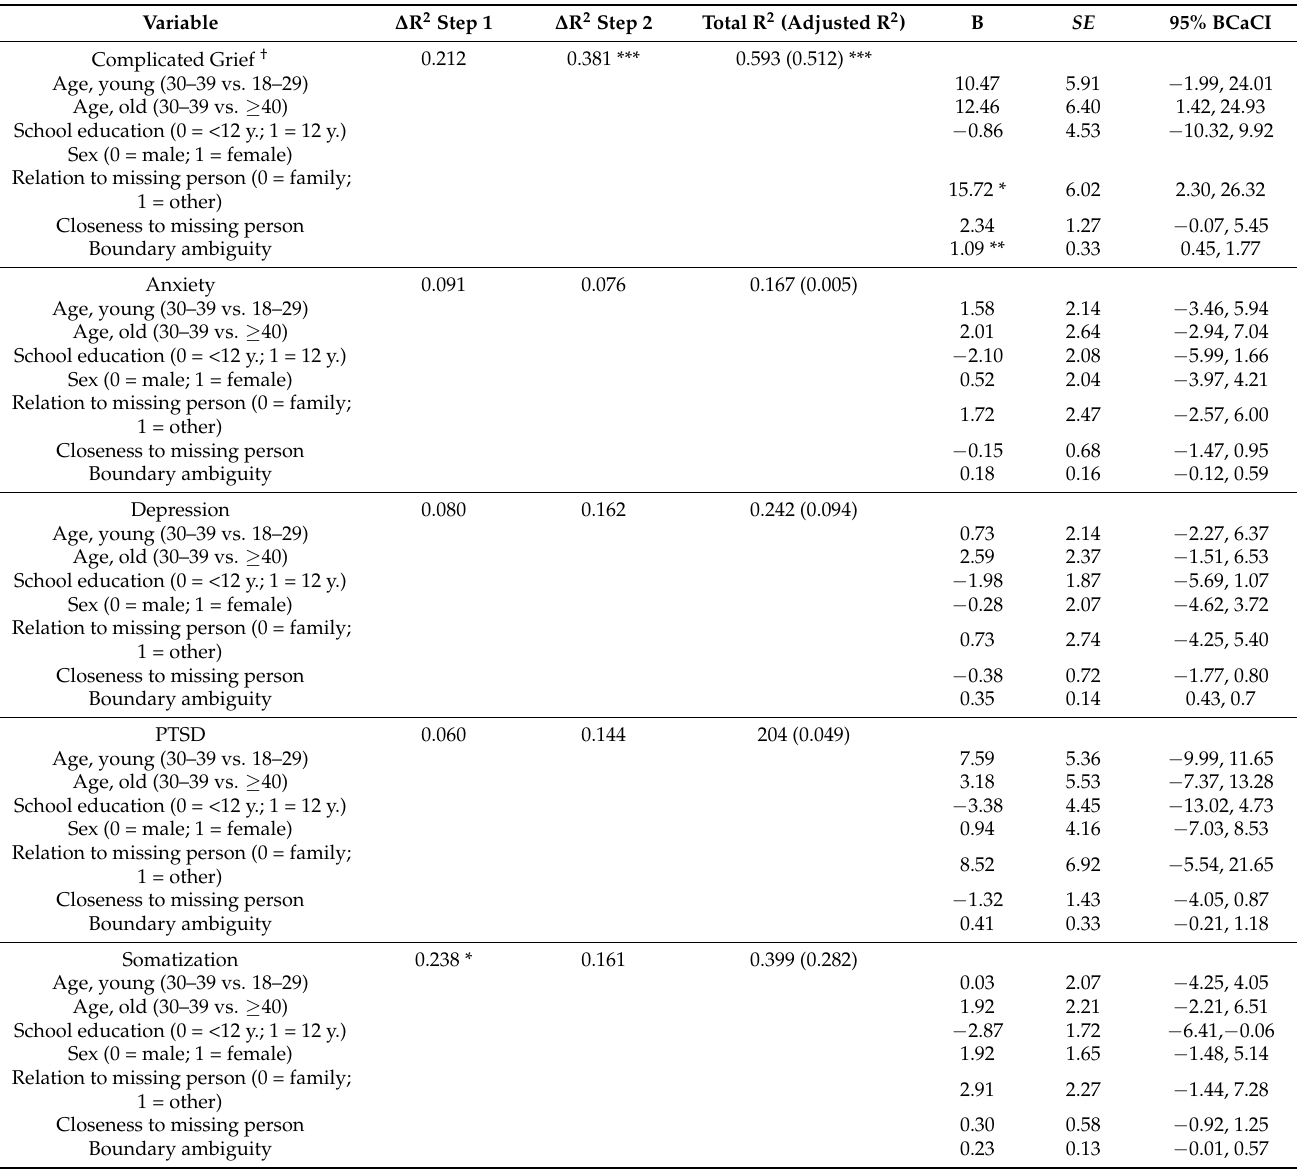
Table 5. Results from bootstrapped multiple linear hierarchical regression analyses (Model